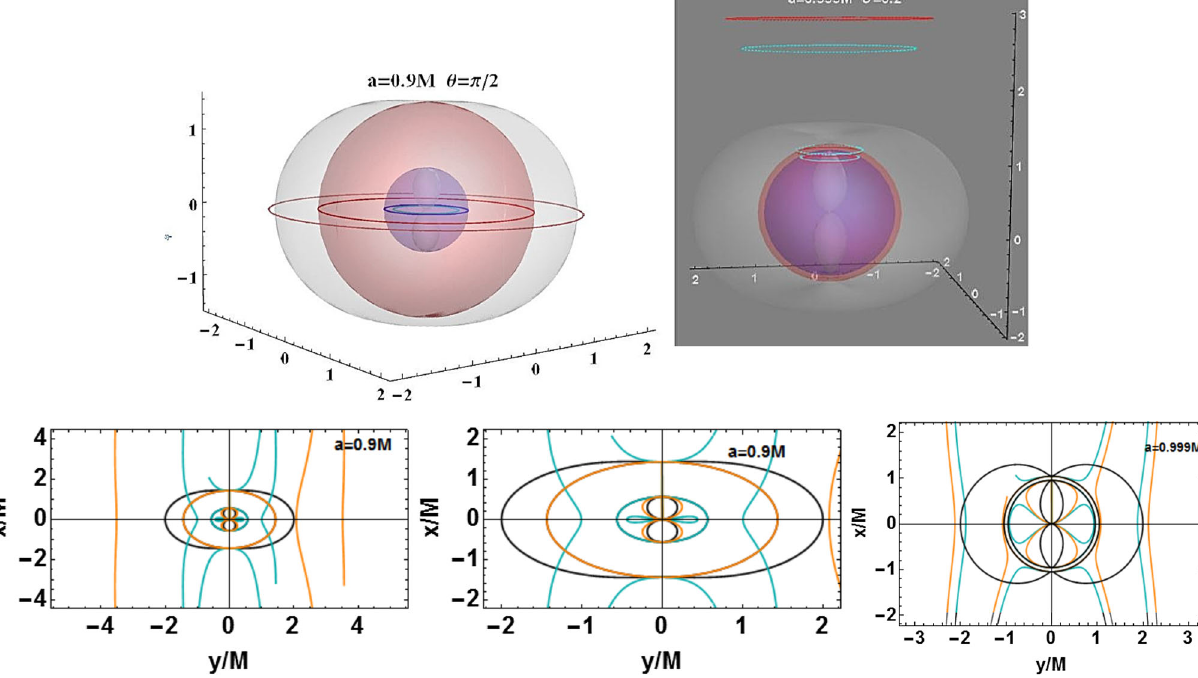
gularity is at r = 0. In the lower panels, the light surface solutions { r 1 , r 2 , r 4 } of Eq. (117) are plotted for ω = ω + s s s (darker cyan). Black curves are the inner and outer ergosurfaces and the inner and outer Killing horizons. These orbits contain replicas of the horizons as defined in Eq.